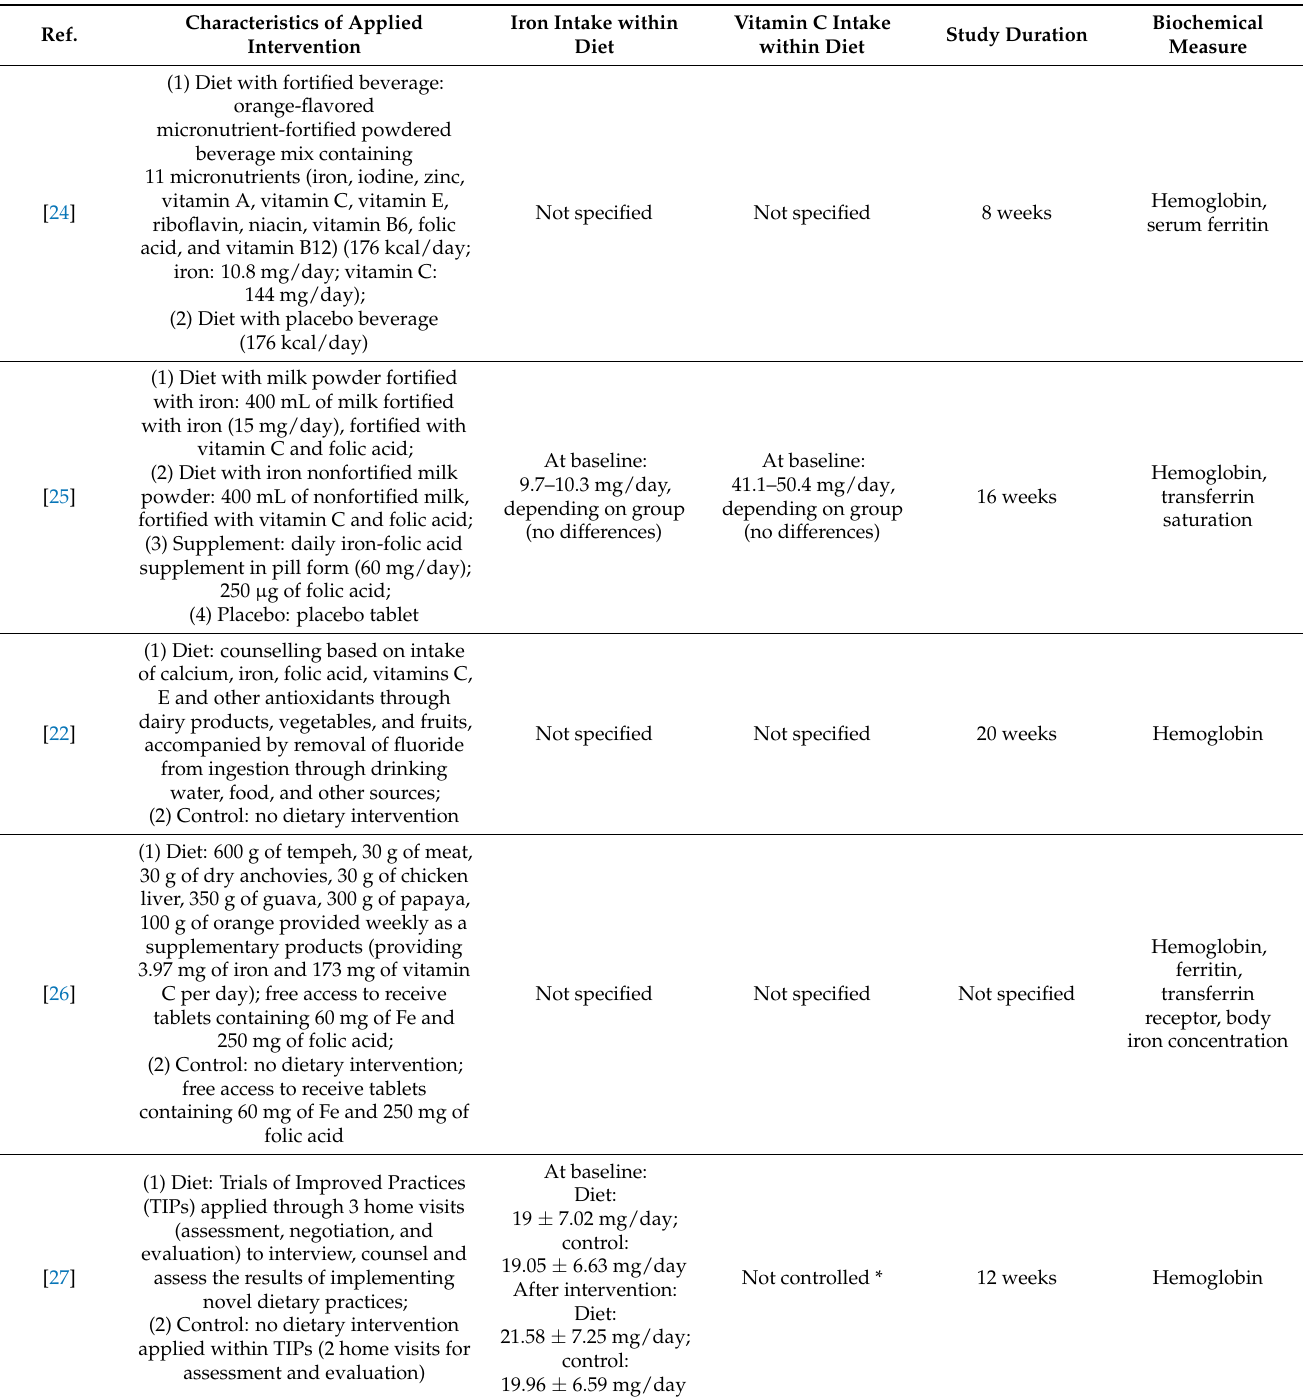
Table 5. The description of the intervention applied within the randomized controlled trials included in the systematic review